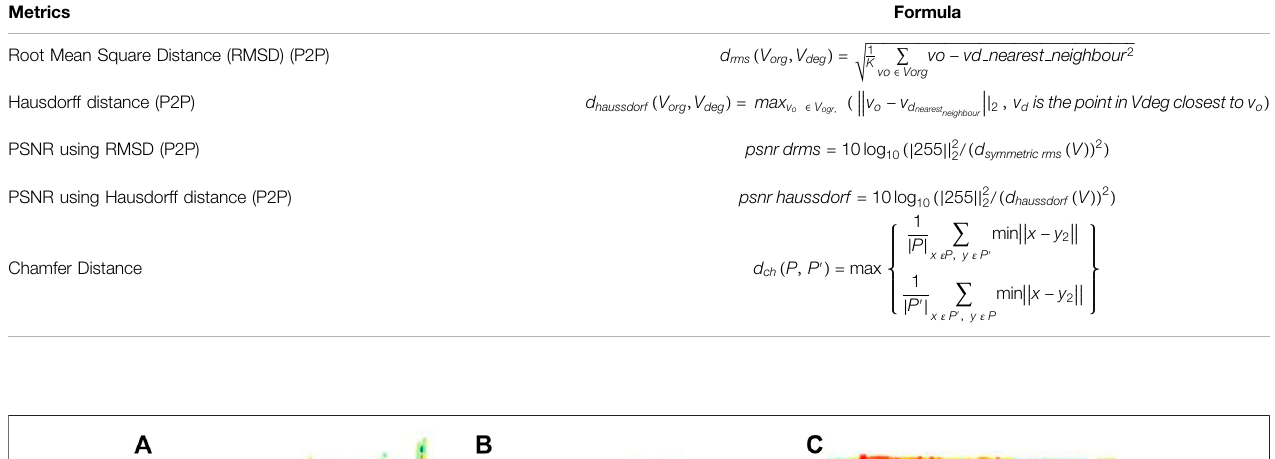
TABLE 1 | The Objective quality metrics of 3D point cloud data. Metrics